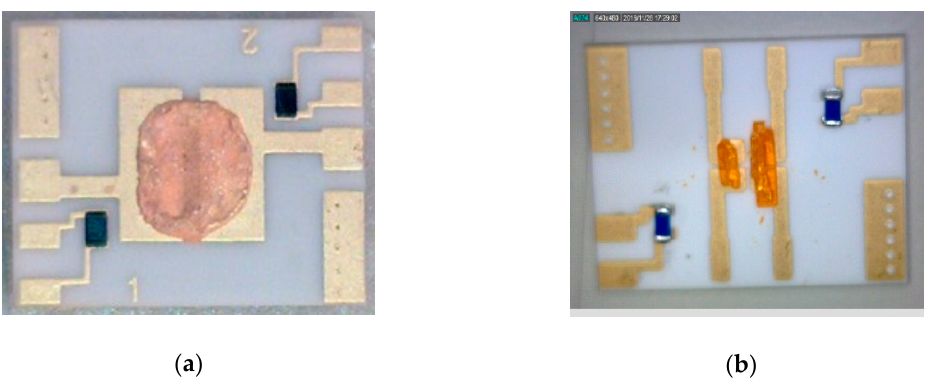
Figure 1. Photograph of ( a ) polycrystalline and ( b ) single crystals CsPbBr 3 deposited on alumina PCB equipped with Au contacts and Pt100 temperature sensors.